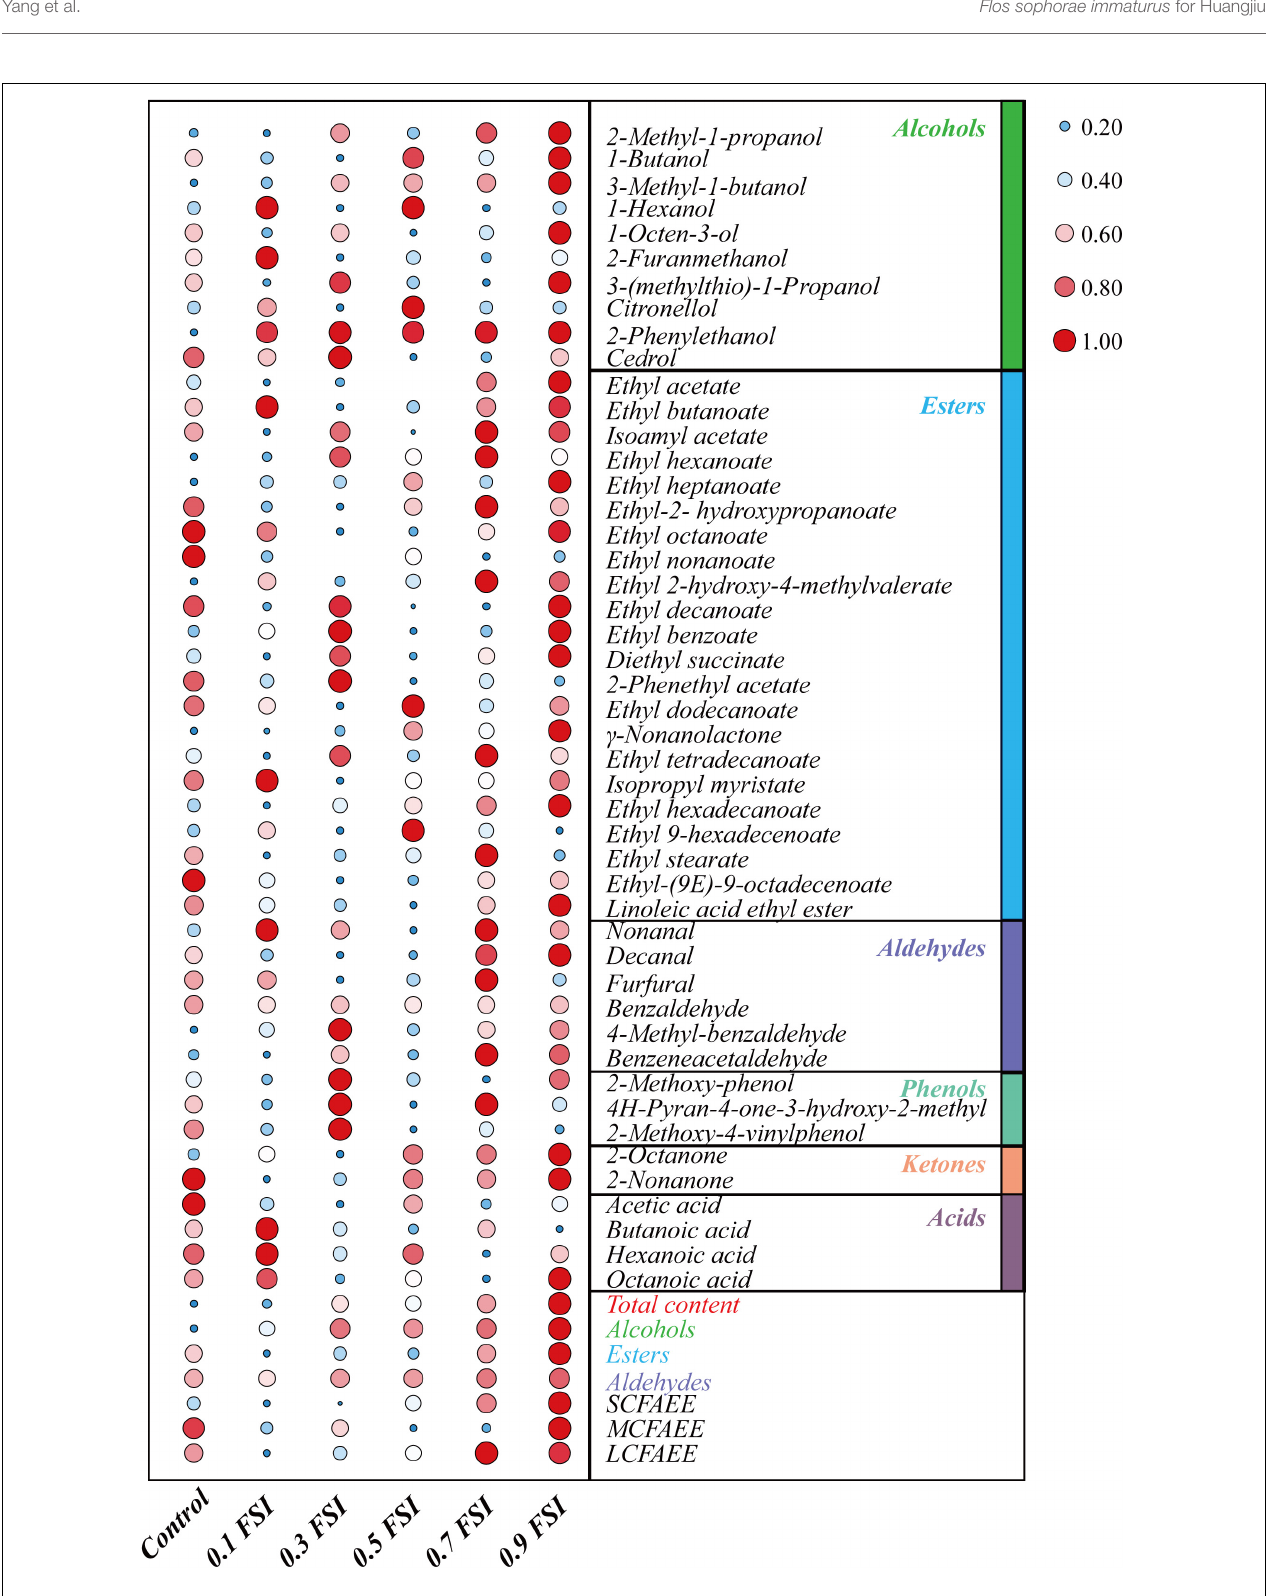
FIGURE 4 | Differentiation of volatile flavor compounds in HQW containing different concentrations of FSI . The 0.1 FSI , 0.3 FSI , 0.5 FSI , 0.7 FSI , and 0.9 FSI represented HQW containing 0.1, 0.3. 0.5, 0.7, and 0.9 mg/mL FSI , respectively. The color and size of the circle represent the relative content of the flavor compound (the data has been standardized). The redder (the bigger) the circle, the higher the content of the flavor compound, and the bluer (the smaller) the circle, the lower content of the flavor compound.